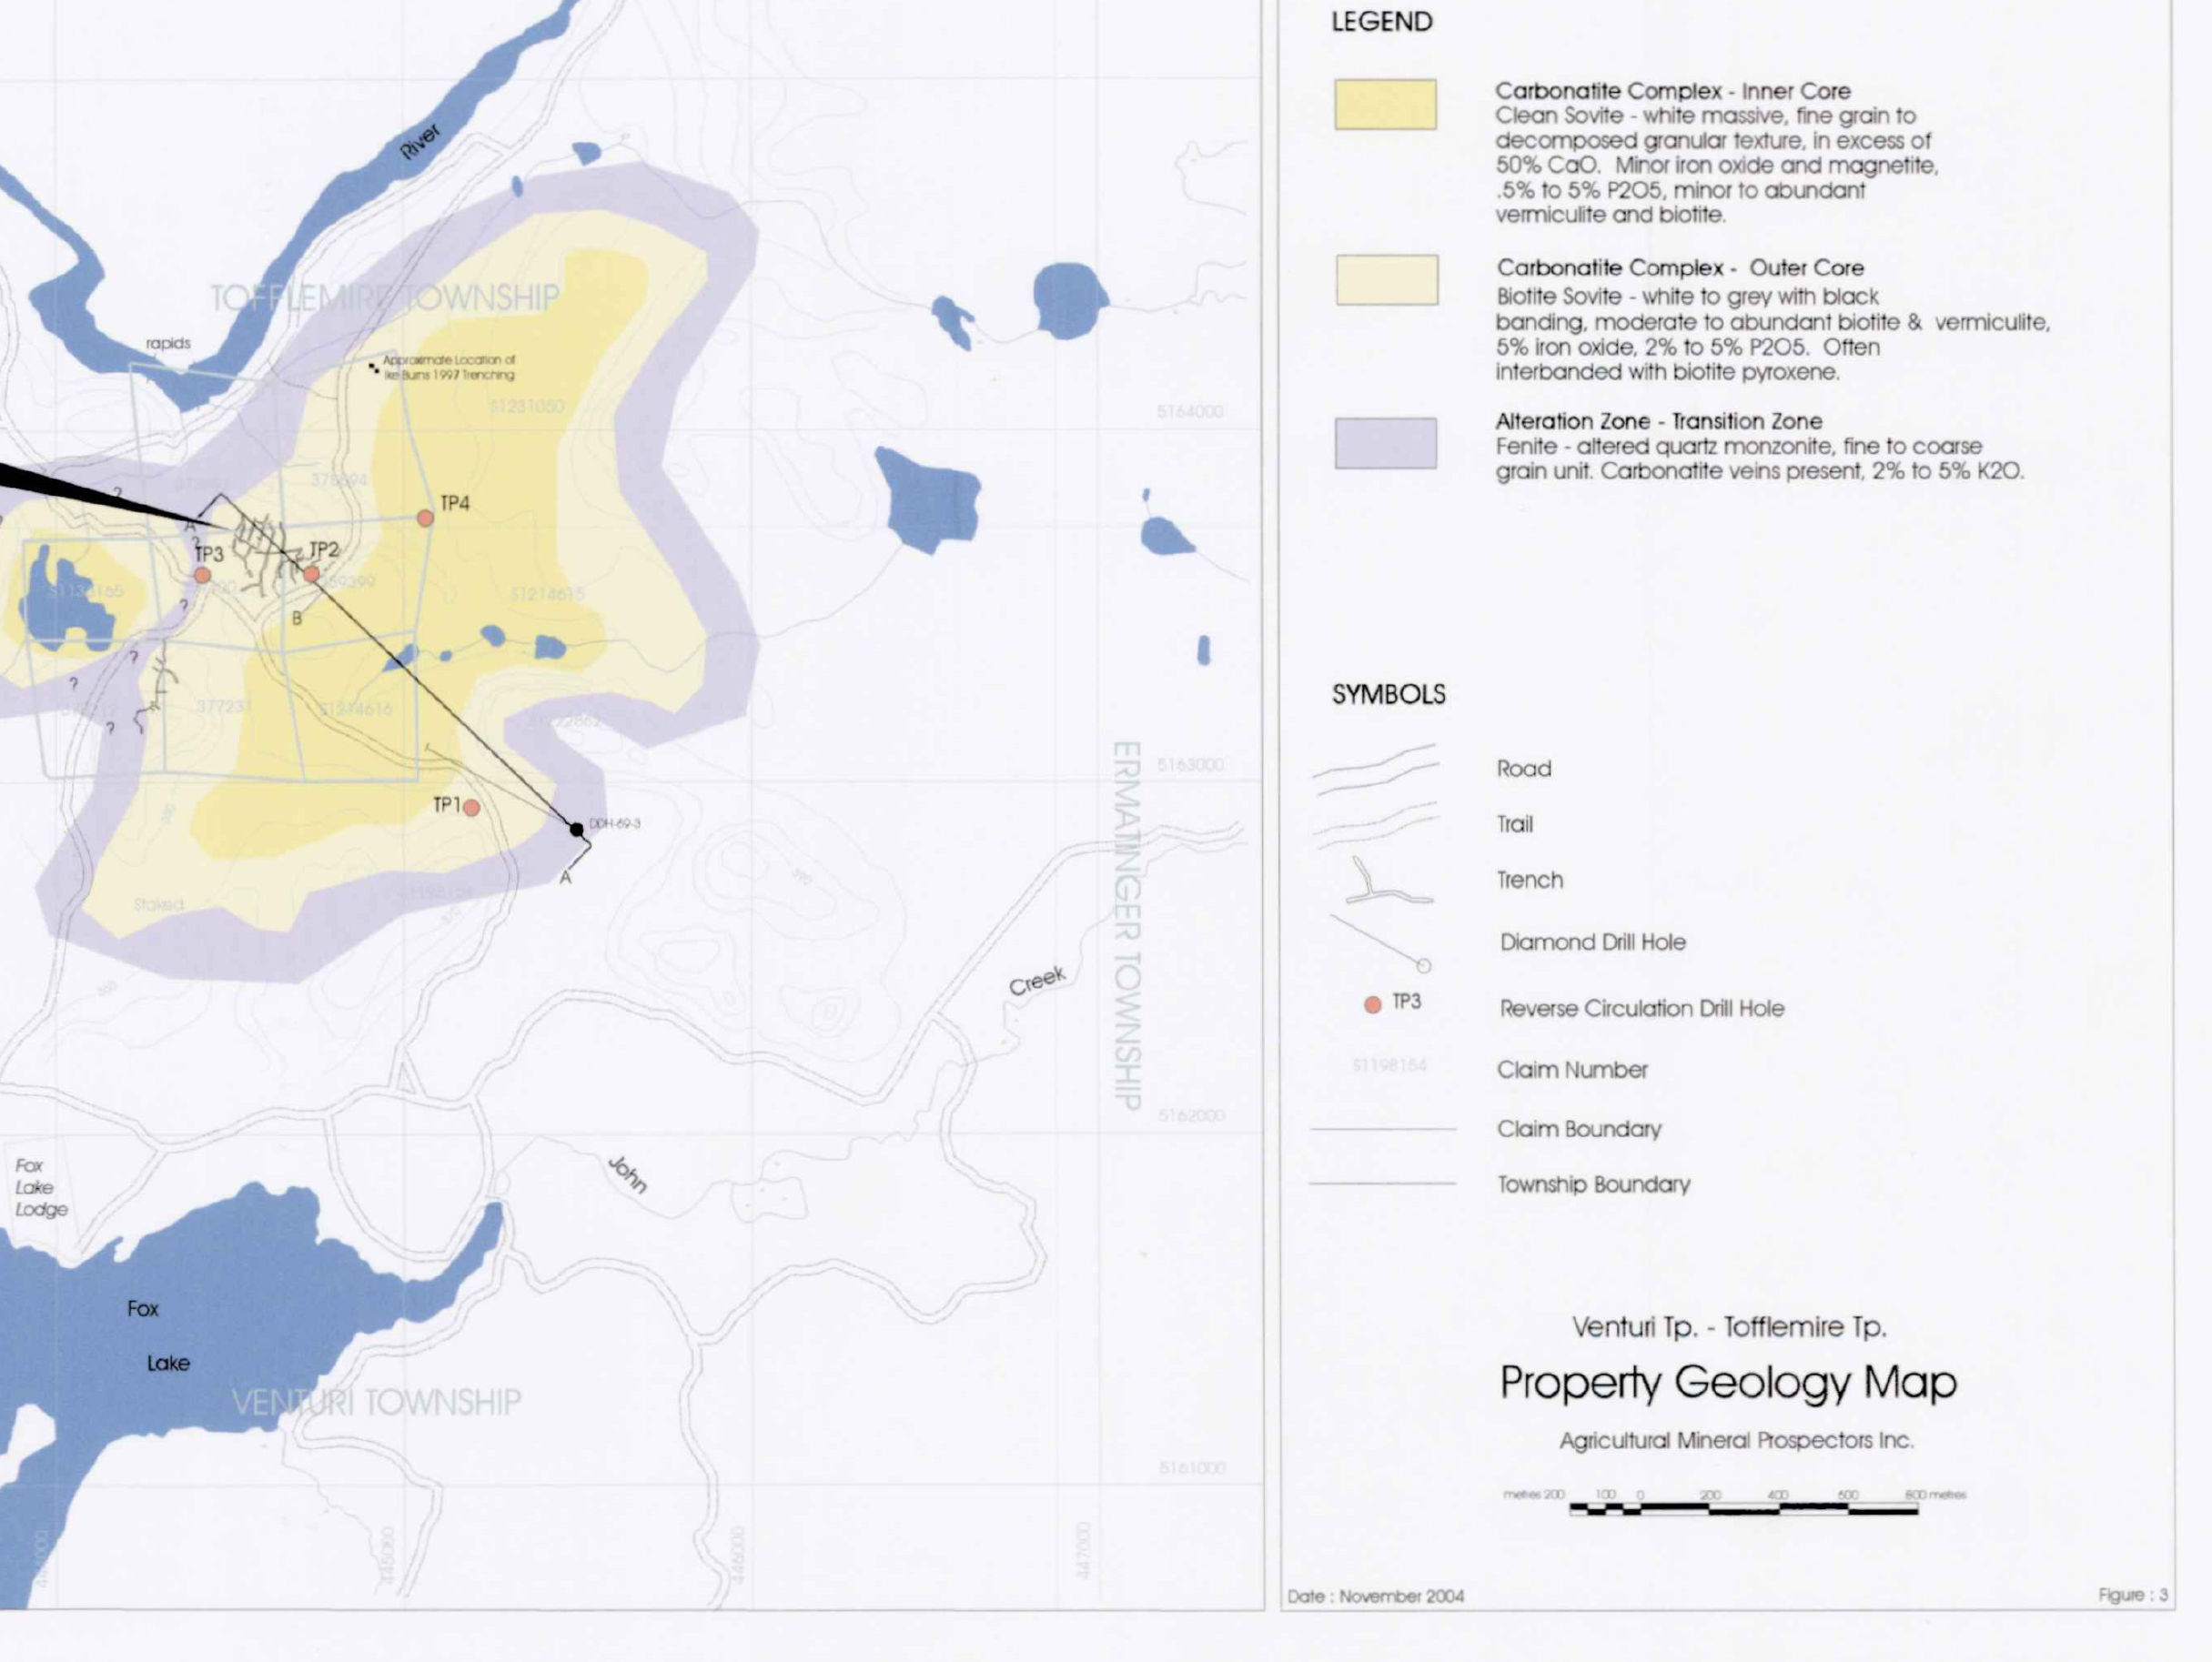
Carbonatite Complex - Inner Core Clean Sovite - white massive, fine grain to decomposed granular texture, in excess of SO'Sb CaO. Mirof iron oxide and magnetite, .5*^ to 5tfe P2O5, minor to abundant vermiculite and biotite. Carbonatite Complex - Outer Core Biotite Sovite - white to grey with black banding, moderate to abundant biotite 8t vermiculite, bVo iron oxide, 2*fc to 5*fc P2O5. Onen interbanded with biotite pyroxene. Alteration Zone - Transition Zone Fenite - ottered quartz monzonite, fine to coarse grain unit. Carbonatite veins present, 2*^ to 5*fc K2O.